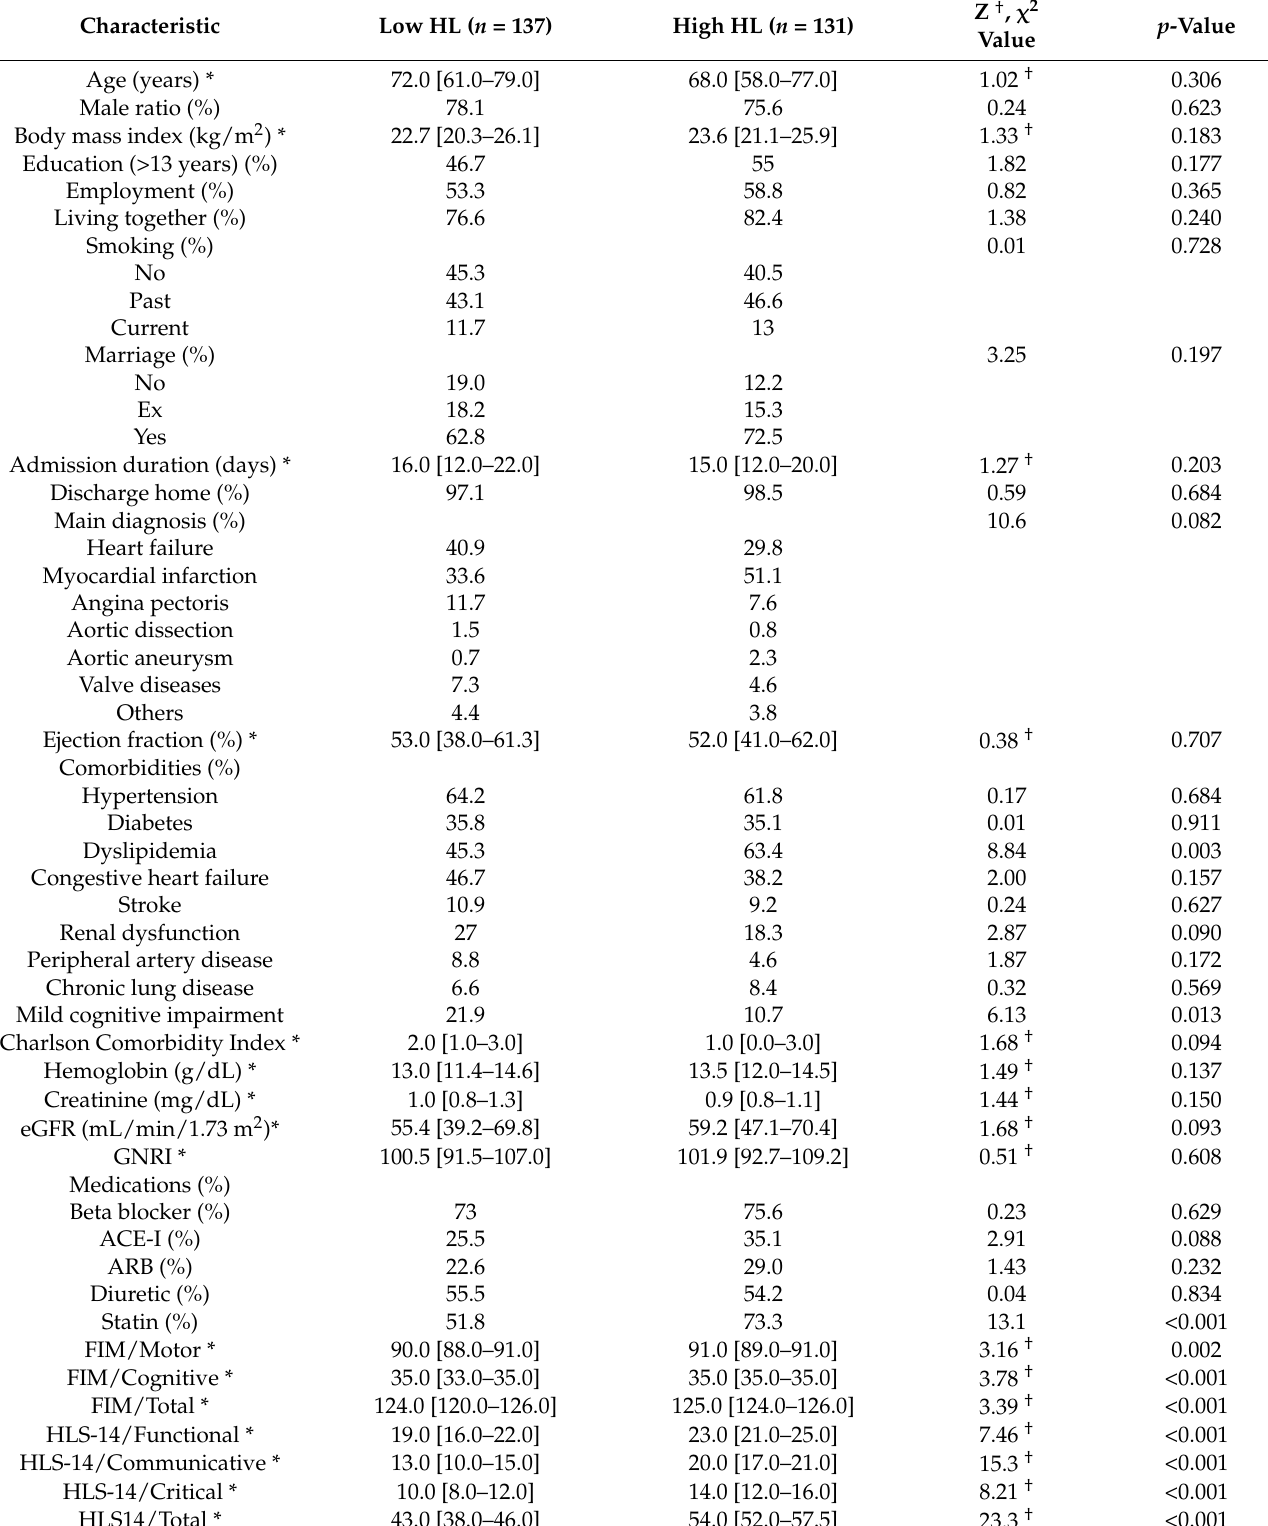
Table 1. Baseline clinical characteristics of the low and high health literacy